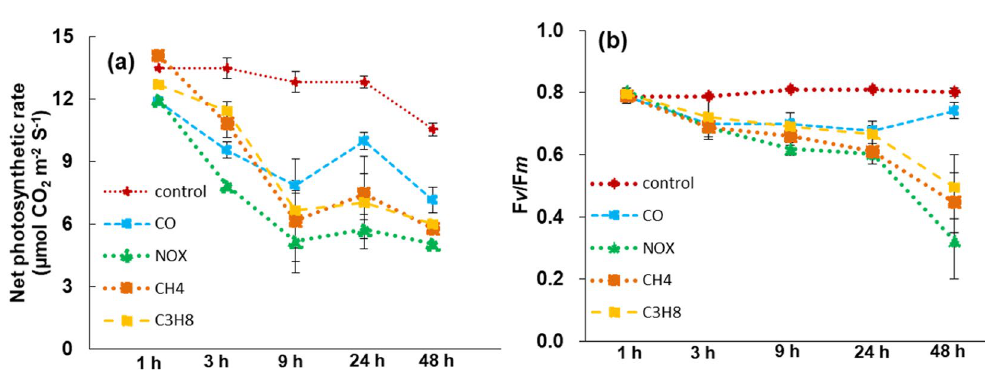
Figure 3. Changes in photosynthetic parameters a photosynthesis rate, b F v /F m ratio as affected by CO indicated by blue line, NO x indicated by green line, CH 4 indicated by orange line and C 3 H 8 indicated by yellow line for 1, 3, 9, 24 and 48 hours after treatment. Lines indicate ± SE of means with n =